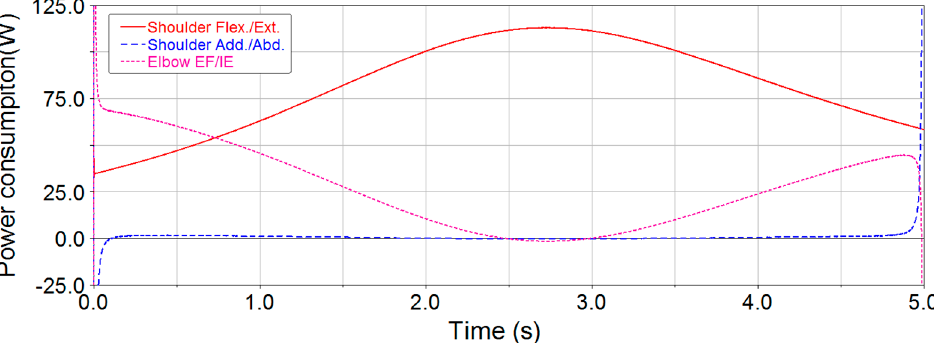
Figure 14. Joint power consumption curves of raising up for the 3 ‐ DOF exoskeleton.